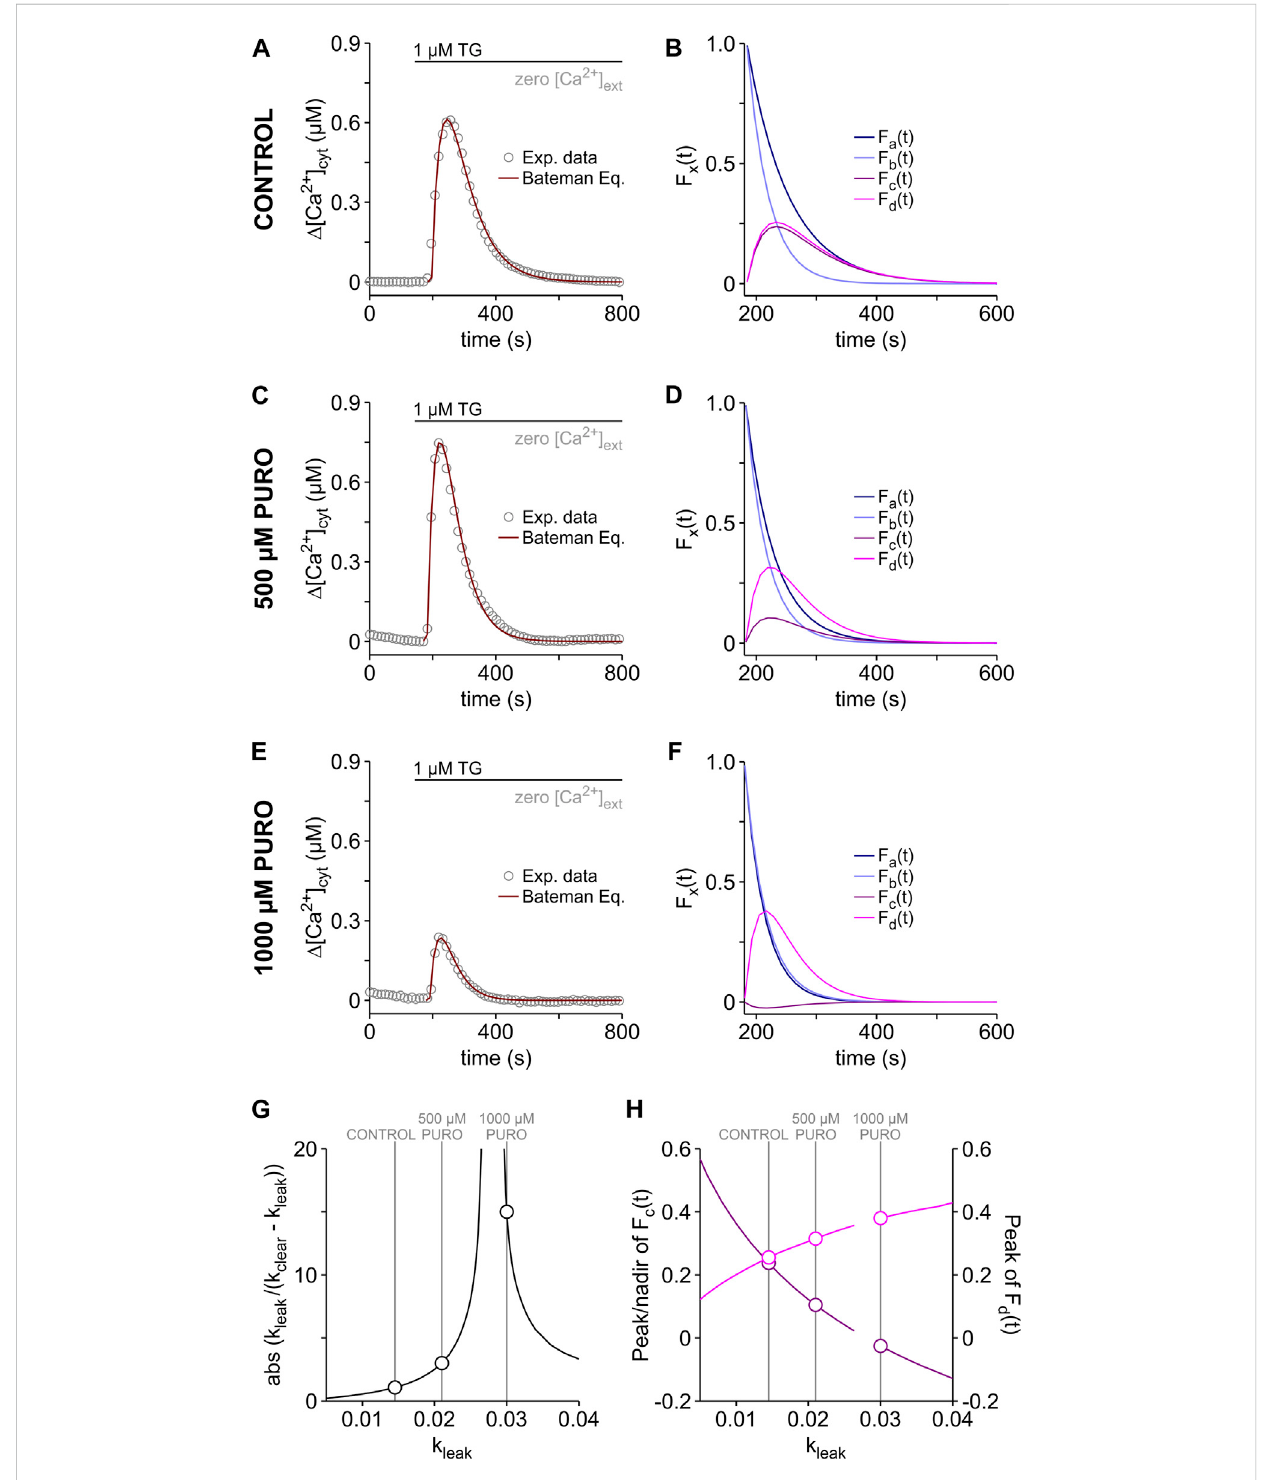
FIGURE 6 ReconstructionofTG-inducedcytosolicCa 2+ transients.TheBatemanequation(Eq.15)wasusedtoreconstructthetimecourseoftheTG-induced Ca 2+ transients recorded in HEK-D1ER cells treated with PURO and in the respective control (see Figure 4A). Shown are the reconstructed cytosolic Ca 2+ transients superimposed on the experimental data (A,C,E) . PURO treatment protocol as in Figure 4A (CONTROL, 500 µM PURO and 1000 µM PURO). k clear was 28.34 e − 3 s − 1 for all experimental conditions. k leak : A , 14.55 e − 3 s -1 ; C , 21.03 e − 3 s − 1 ; E , 30.07 e − 3 s − 1 . b[Ca 2+ ] lER : A , 2.40 µM; C , 2.38 µM; E , 0.62 µM. In order to visualize the procedure of reconstruction, the Bateman equation was broken down in single terms as follows: F a (t) = exp (-k leak · t); F b (t) = exp (-k clear · t); F c (t) = exp (-k leak · t) - exp (-k clear · t) and F d (t) = (k leak /(k clear - k leak )) · (exp (-k leak · t) - exp (-k clear · t)). The curves obtained in the breakdown of the Bateman equation are shown for controls (B) and for cells treated with 500 µM PURO (D) and 1000 µM PURO (F) . The dependence of the term [k leak /(k clear - k leak )] on k leak is shown in (G) . The peak and nadir values of F c (t) (dark pink) and F d (t) (pink) are depicted as a function of k leak in (H) . Breaks in the curves of (G,H) are located around k leak = k clear . The values for CONTROL, 500 µM PURO and 1000 µM PURO are highlighted in (G,H)